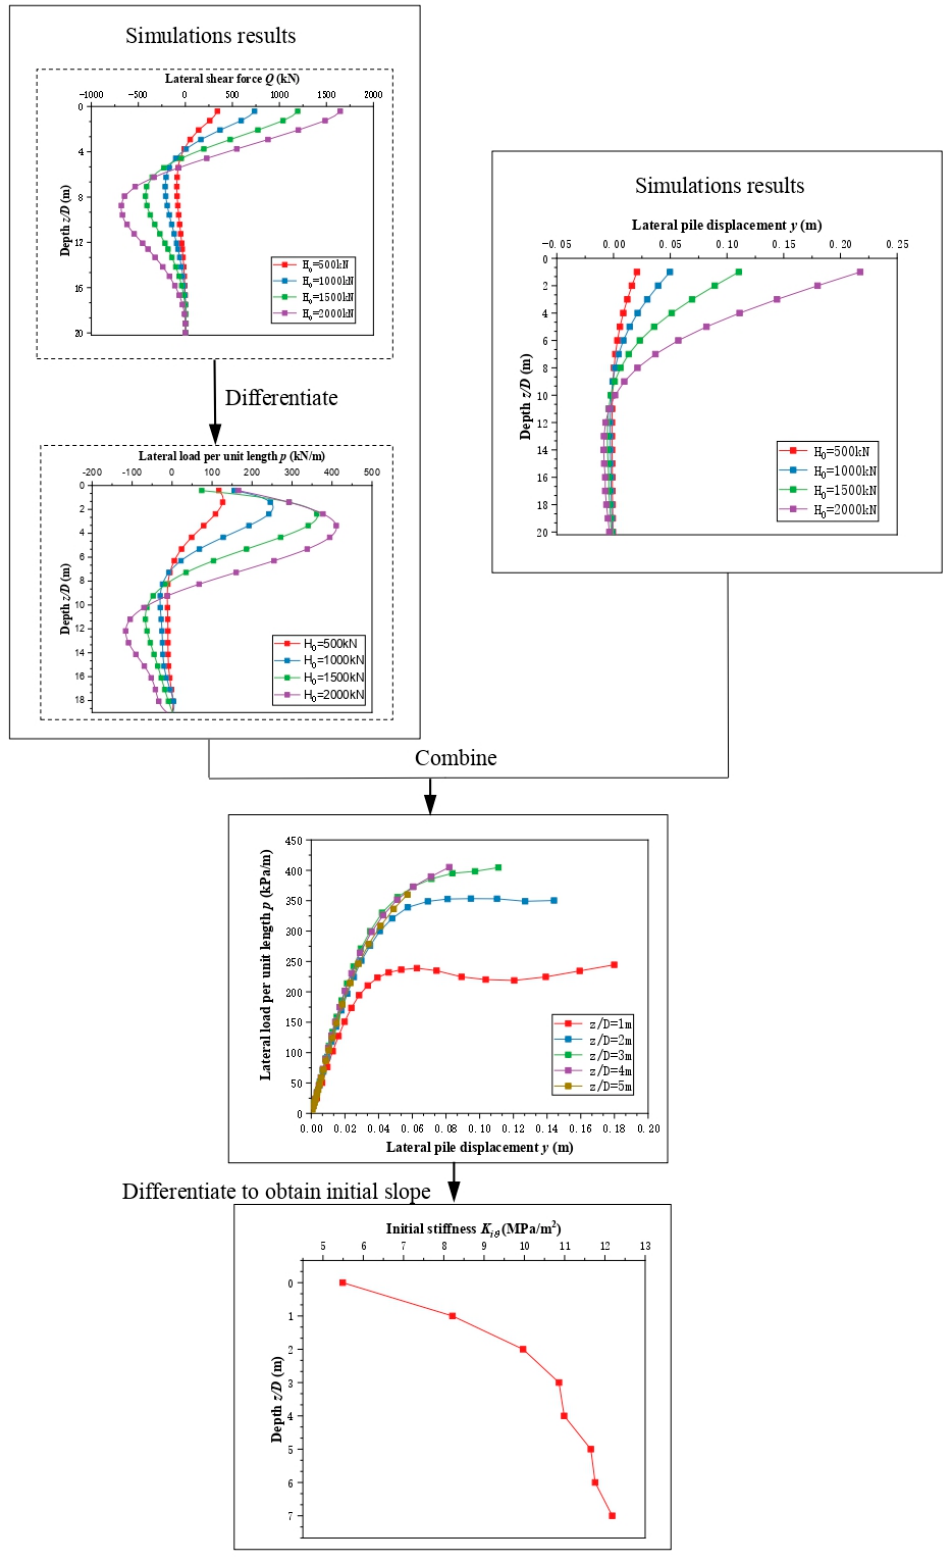
Figure A1. Process of deriving K i θ from simulation